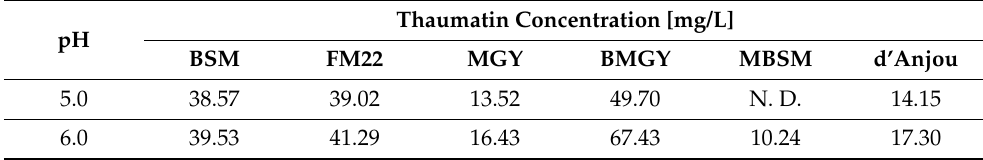
Table 2. Concentration of thaumatin quantified at the end of fermentation using SDS PAGE densito- metric analysis.